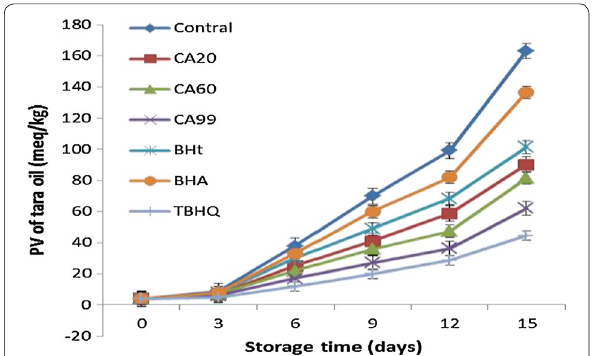
Fig. 1 PV results for tara seed oil samples after accelerated